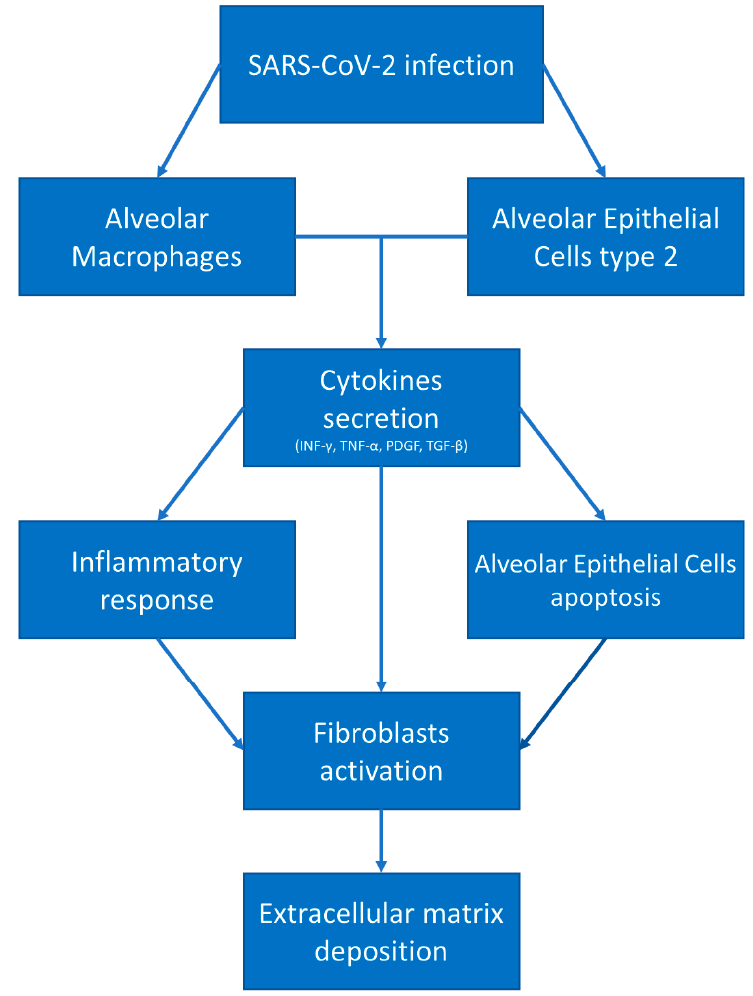
Figure 1. COVID-19 and fibrotic damage. After SARS-CoV-2 infection, alveolar macrophages and alveolar epithelial cells type 2 secrete pro-inflammatory and pro-fibrotic cytokines, leading to fibroblast activation and differentiation in myofibroblasts, resulting in extracellular matrix deposition.